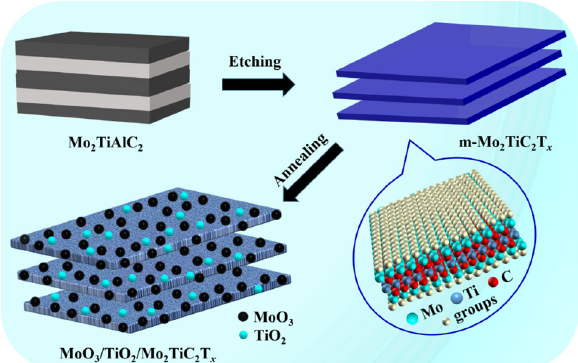
Fig. 1 Schematic diagram of the preparation of MoO 3 / TiO 2 /Mo 2 TiC 2 T x hybrids.